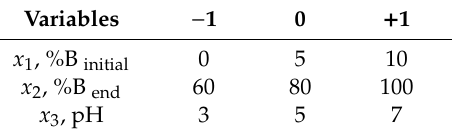
Figure 1. A 15-run experiment of the Box–Behnken Design (BBD). Table 1. Selected variables and their levels.